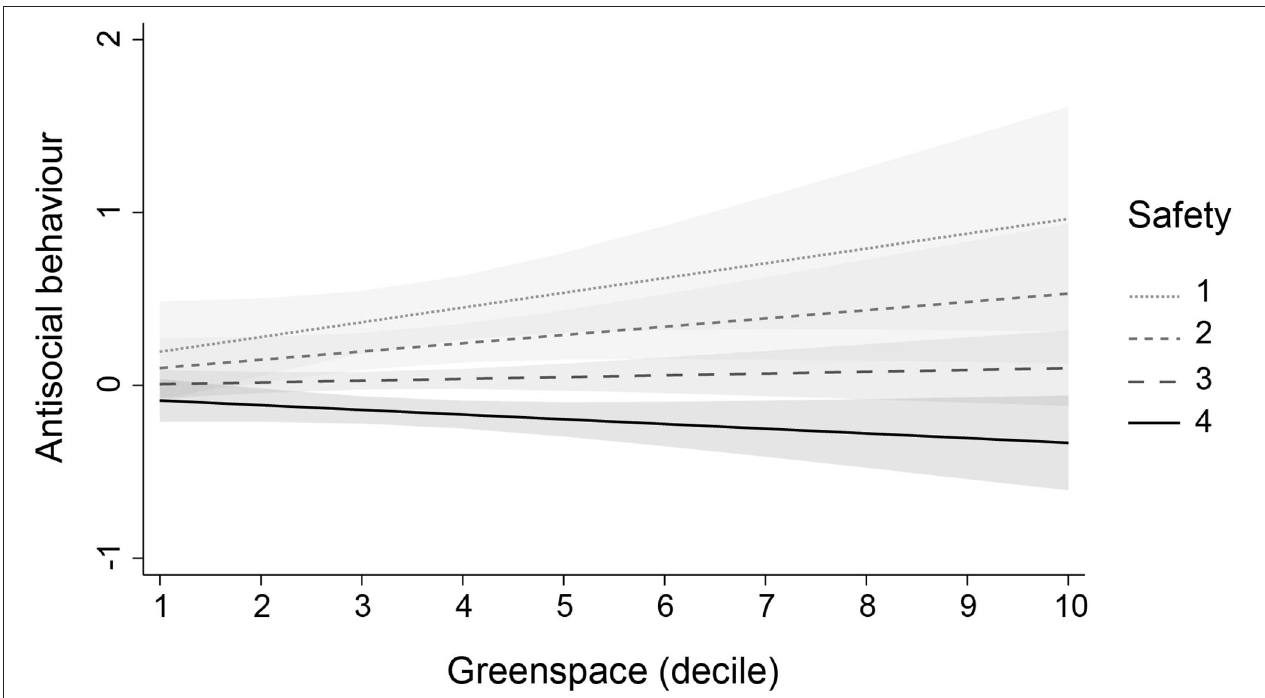
FIGURE 4 | Moderation of the effect of greenspace on antisocial behaviour by area safety. This plot illustrates the moderating role of perceived area safety in the association of greenspace with antisocial behaviour (linear predictions). Plots are based on non-imputed data. Shaded areas are 95% confidence intervals. Perceived area safety ranged from 1 “not at all safe” to 4 “very safe.” Please note that, for visual clarity, the y-axis does not cover the whole scale of antisocial